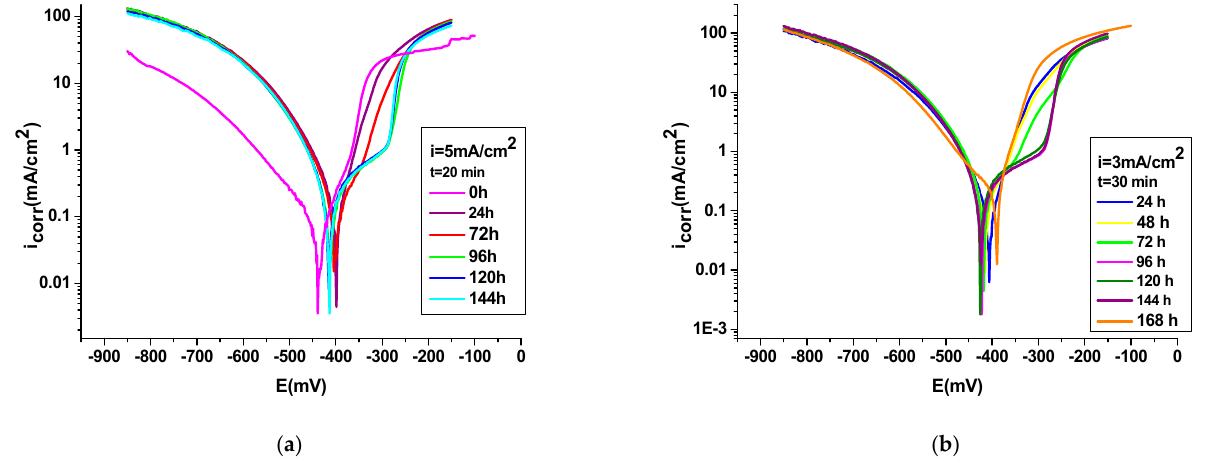
Figure 8. Polarization curves MPY-TRX100/NNDEA-coated and -uncoated OL 37 electrode in 0.5 M H 2 SO 4 by electrodeposition at 5 mA/cm 2 ( a ) and 3 mA/cm 2 ( b ) in different molar ratios where the deposition was allowed for 20 and 30 min at different immersion times.